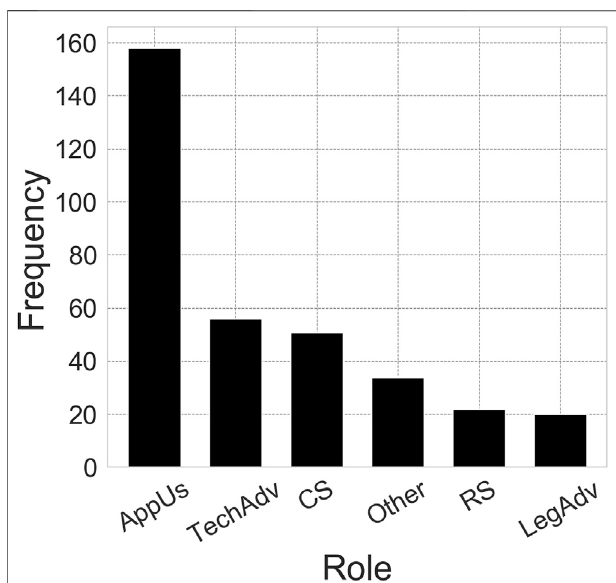
FIGURE 4 | Distribution of roles.